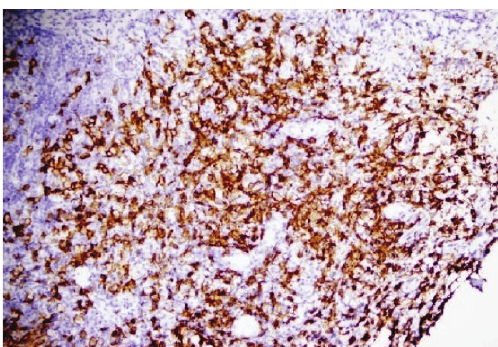
Figure 3: Histopathological assessment. Groups of cells with irreg- ular and notched nuclei and acidophilic cytoplasm.